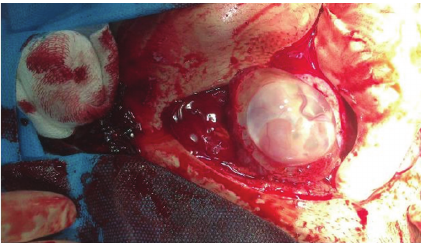
Figure 2: Intact gerstational sac along with placental tissue seen protruding through previous cesarean sacr